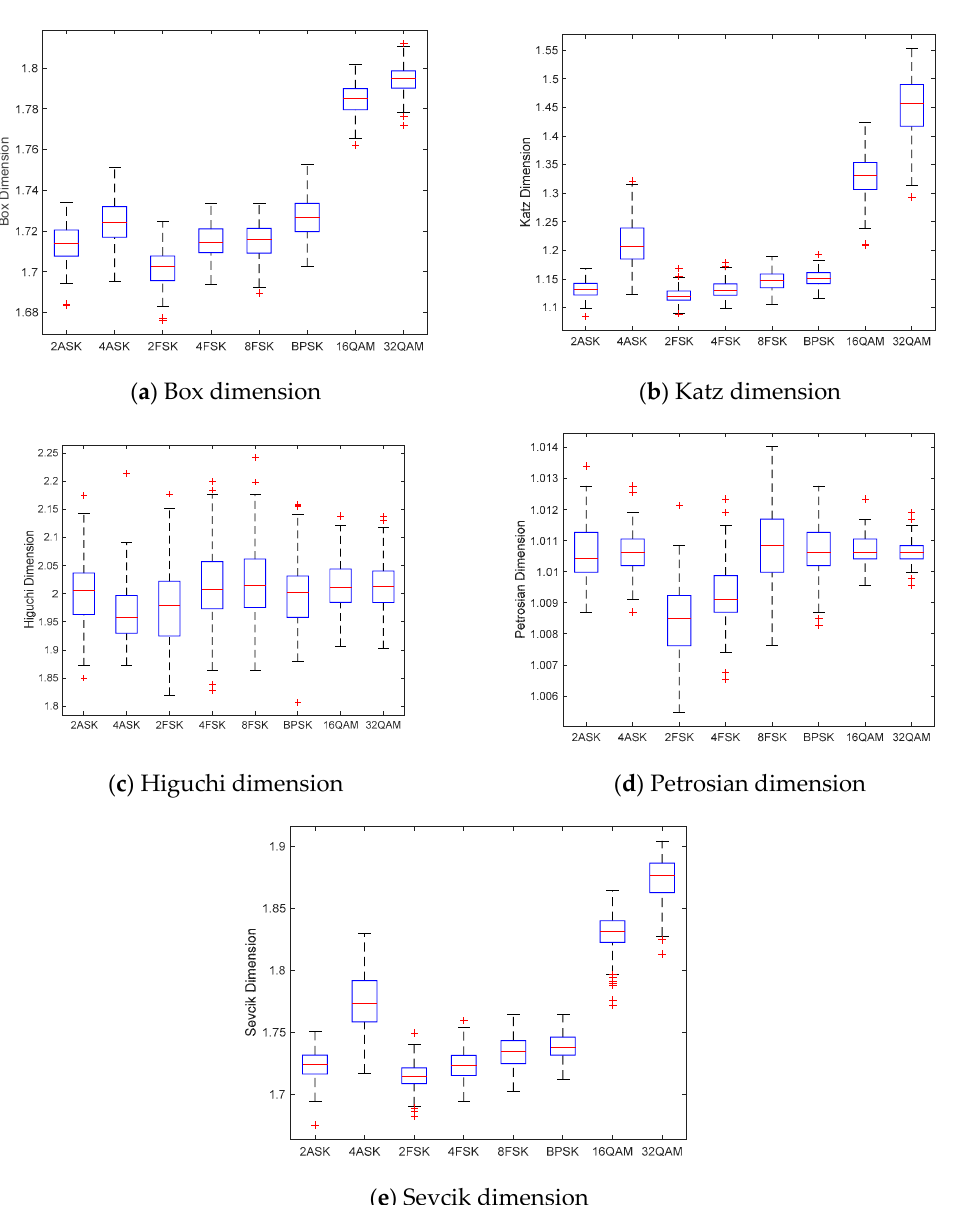
Figure 4. Characteristic box diagram evaluation of five different fractal dimensions.